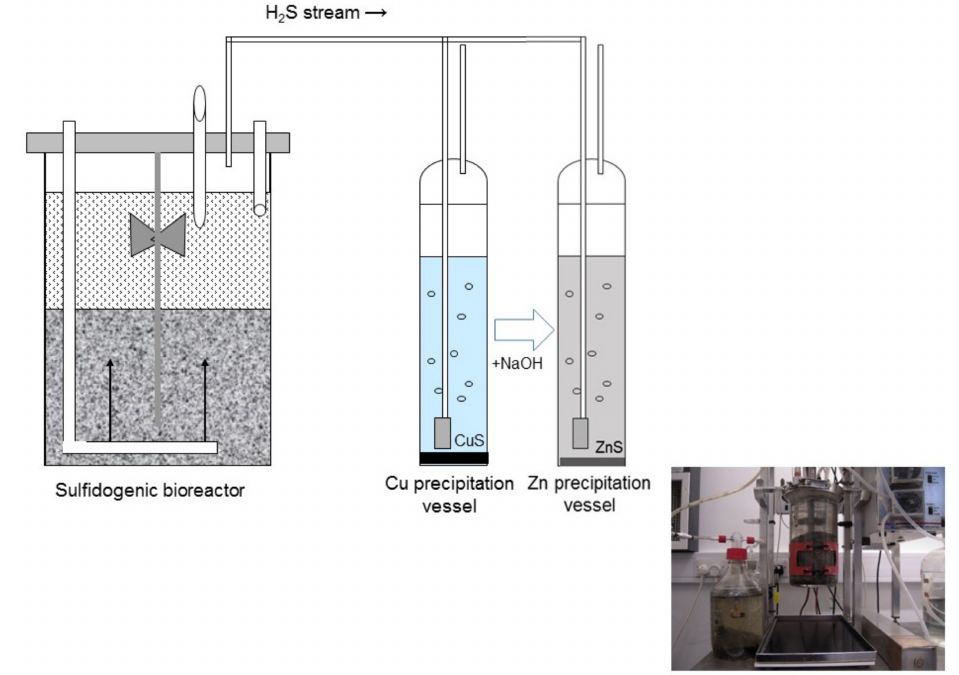
Figure 7. The schematic representation of the protocol used to remove copper and zinc selectively from the Afon Goch mine drainage stream, and ( inset ) an image of a low pH sulfidogenic bioreactor ( centre ) being used to precipitate copper in an off-line vessel ( left